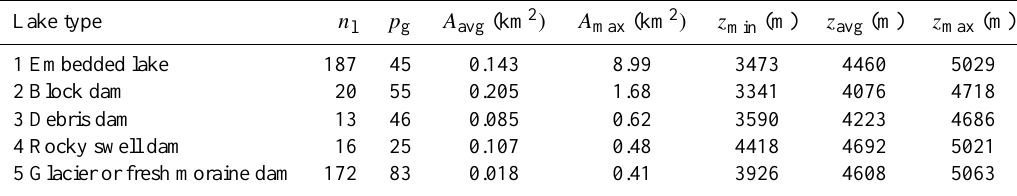
Table 8. Lake statistics, organized by lake type. n l = number of lakes, p g = percentage of growing lakes, A avg and A max = average resp. maximum lake area, z min , z avg and z max =minimum, average and maximum elevation a.s.l. Lake type n l p g A avg (km 2